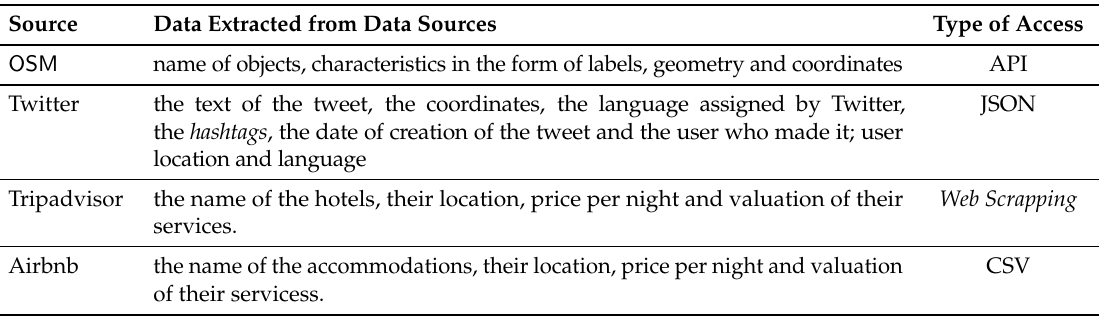
Table 1. Summary of data sources.